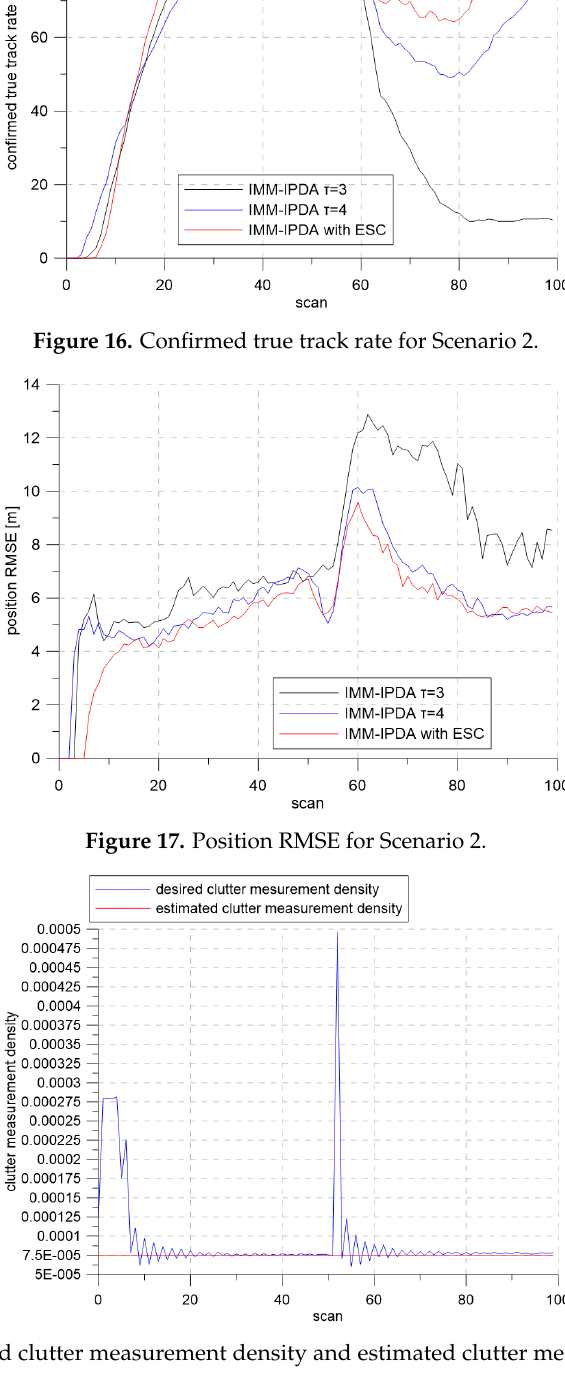
Figure 18. The desired clutter measurement density and estimated clutter measurement density for Scenario